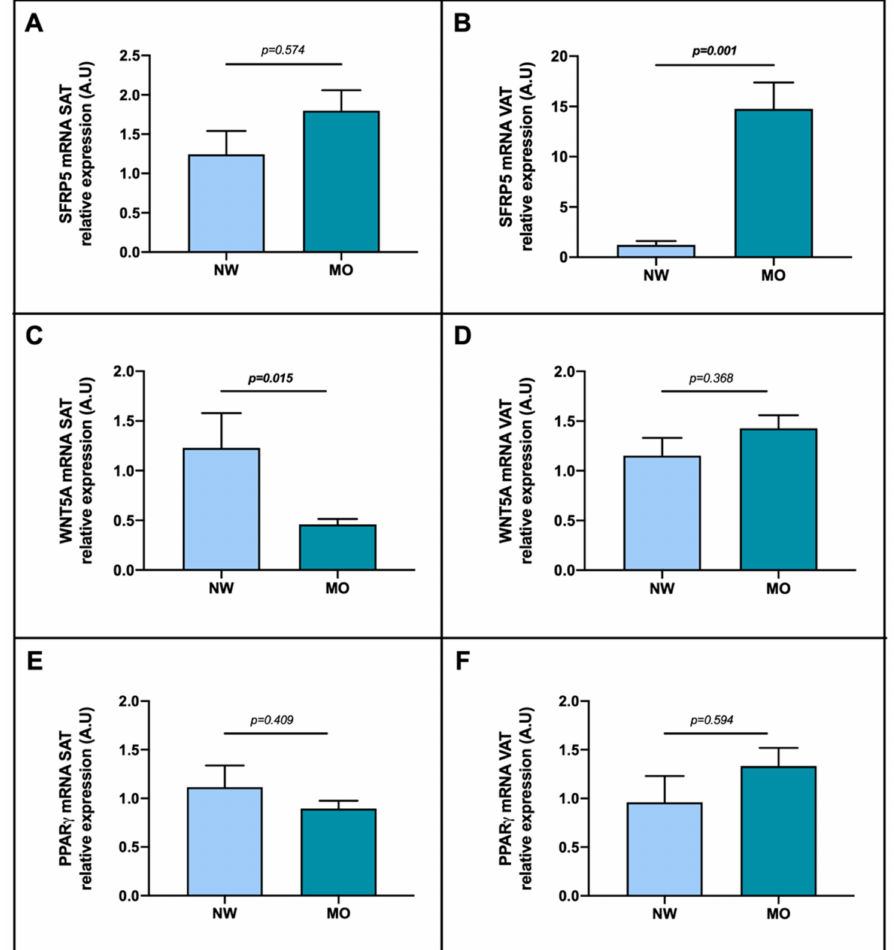
Figure 3. Differential relative mRNA abundance of ( A ) SFRP5, ( C ) WNT5A and ( E ) PPAR γ in subcutaneous adipose tissue and ( B ) SFRP5, ( D ) WNT5A and ( F ) PPAR γ in visceral adipose tissue of women classified depending on their BMI in NW and MO. The data were normalized by NW group and expressed as mean standard error of the mean (SEM). SAT, subcutaneous adipose tissue; VAT, visceral adipose tissue; SFRP5, secreted frizzled-related protein 5; WNT5A, WNT family member 5a; PPAR γ , peroxisome proliferator-activated receptor gamma; NW, normal weight; MO, morbid obesity; A.U arbitrary units. p < 0.05 was considered statistically significant